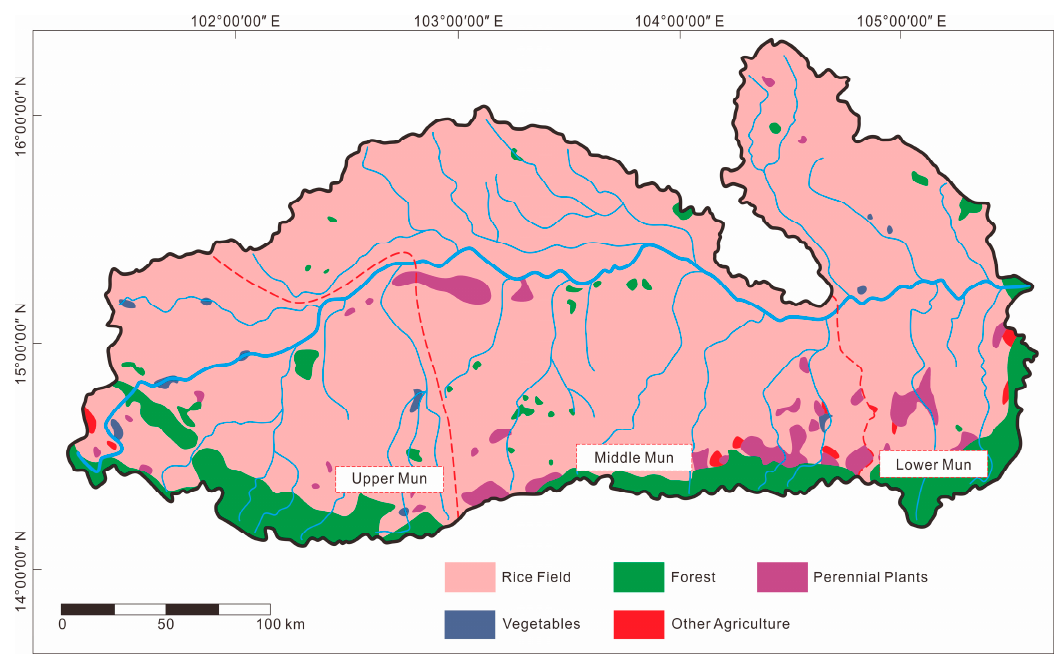
Figure 3. Agricultural land use map of the Mun River Basin (land use data from Akter and Babel [19]).